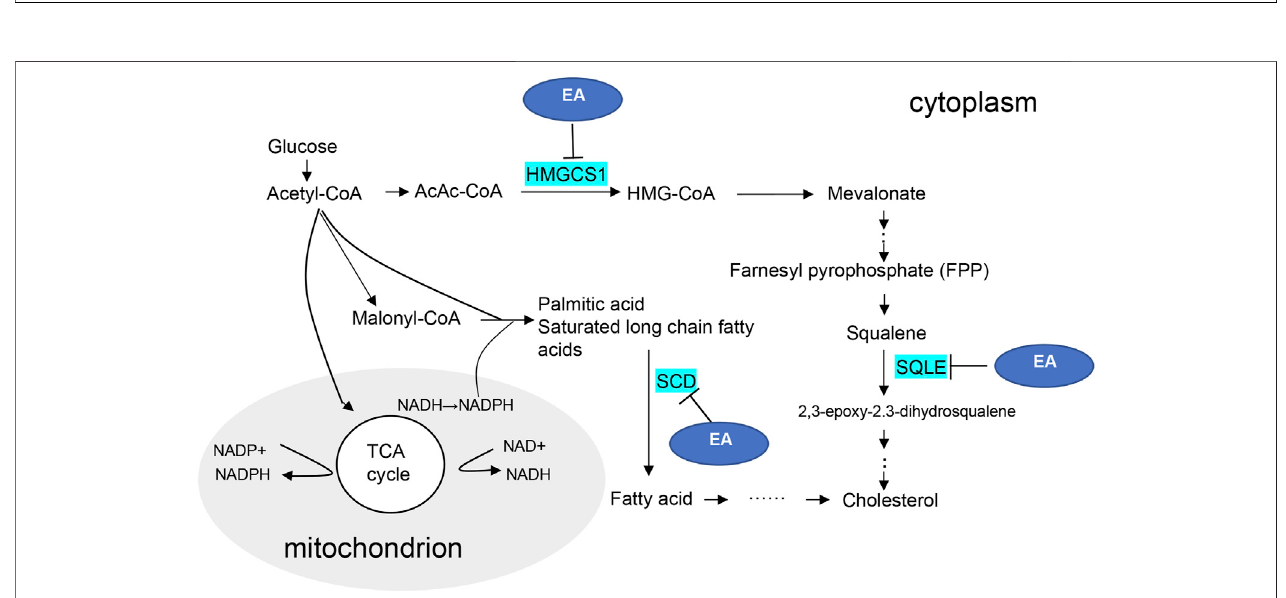
FIGURE 7 | Diagram of the putative regulatory mechanisms of the ellagic acid.